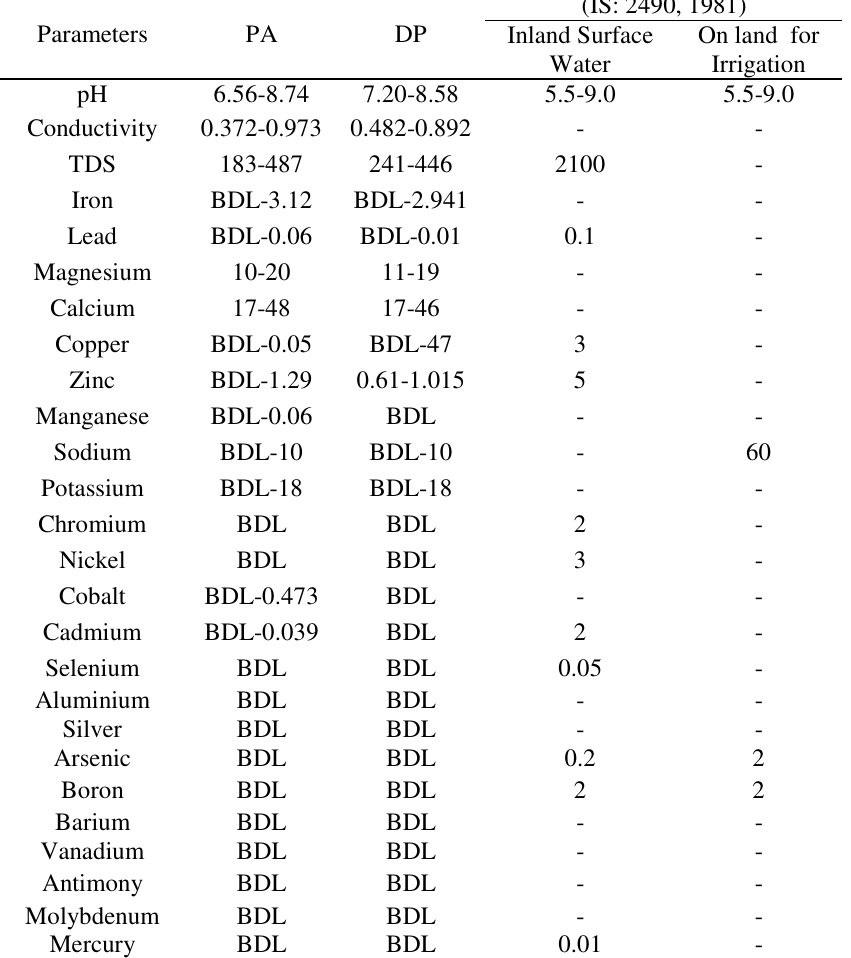
Table 2. Leachate analysis from open percolation experiments of CCRs samples, PA and disposal point effluents